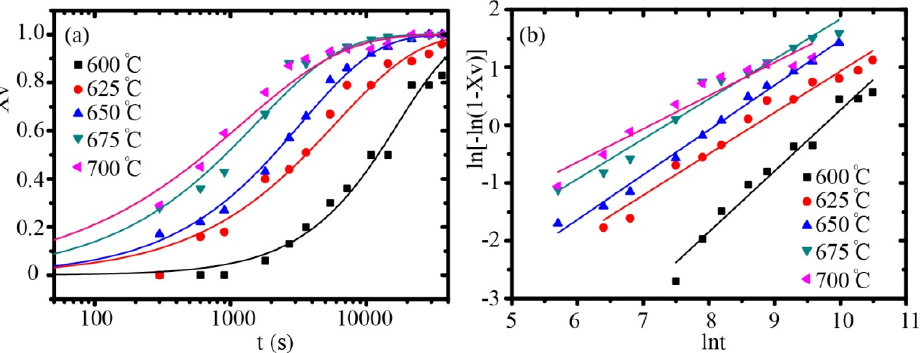
Figure 8. Recrystallization kinetics of 60% cold drawn Cu–Cr–In alloy by Johnson–Mehl–Avrami– Kolmogorov plot for di ff erent annealing conditions. ( a ) t − X V , ( b ) ln t − ln[ − ln(1 − X V